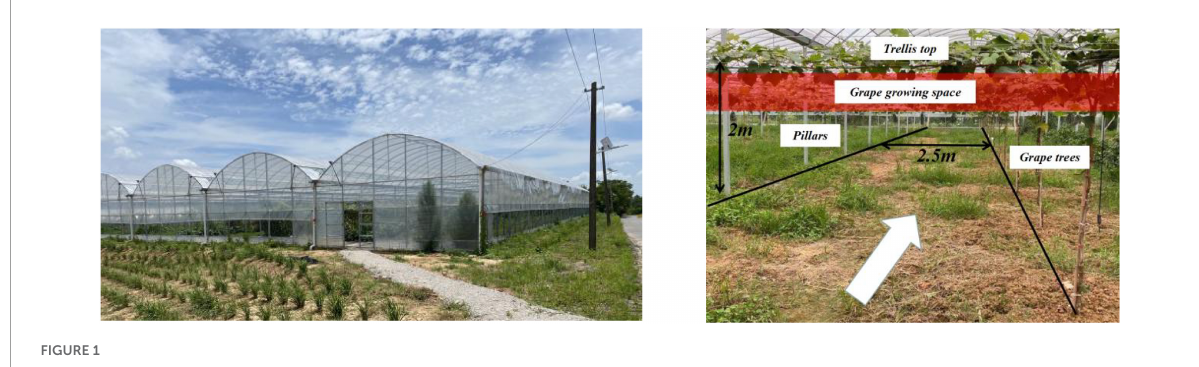
FIGURE1 Vineyard in Jurong City.